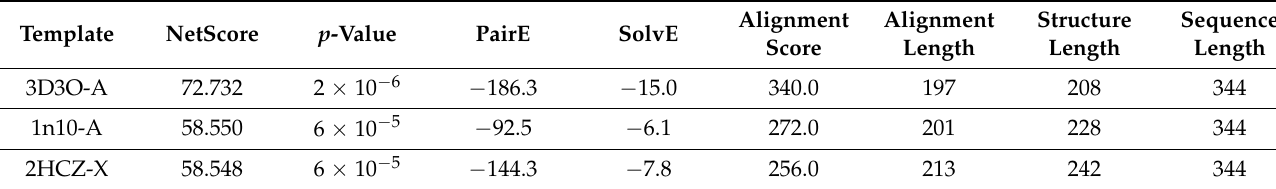
Table 1. Template search results from psipred.